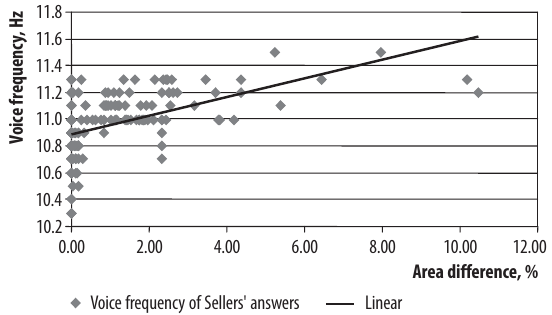
H z , c y e n q u r e e f i c V o Figure 6. The chart which illustrates the trends of relation between voice frequency and area difference